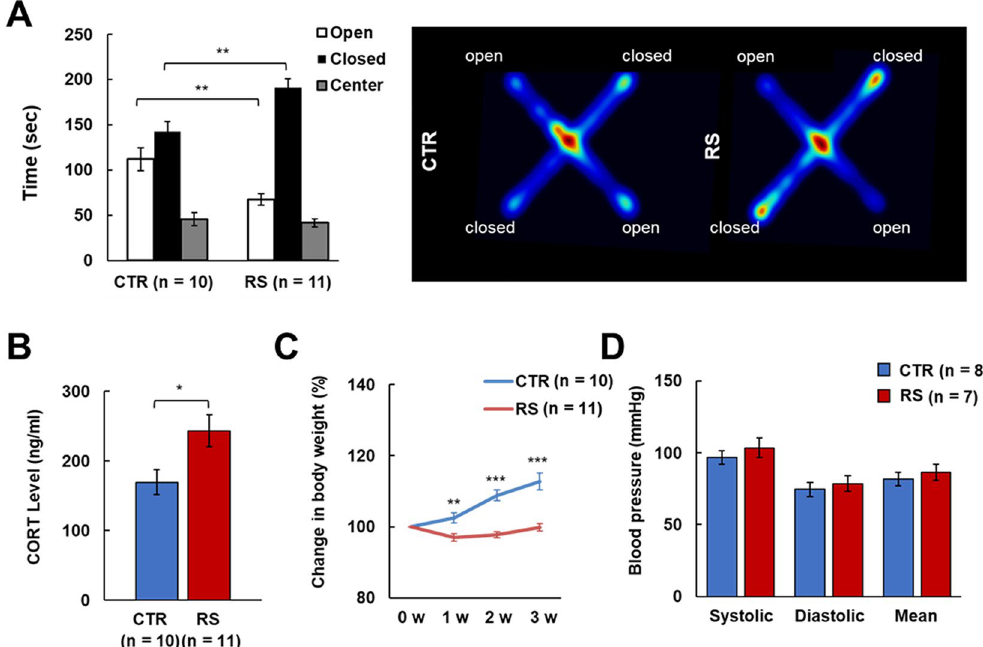
Figure 1. Validation of the chronic restraint stress (RS) animal model. ( A ) Cumulative time in open, closed, and center areas in the elevated plus maze (EPM), and heat map of animals’ movements on the EPM. ( B ) The level of plasma corticosterone (CORT) one day after the last stress exposure. ( C ) Body weight changes over the 3-week period. ( D ) Blood pressure one day after the last stress exposure. CTR, control group; RS, restraint stress group; * p < 0.05; ** p < 0.01; *** p <